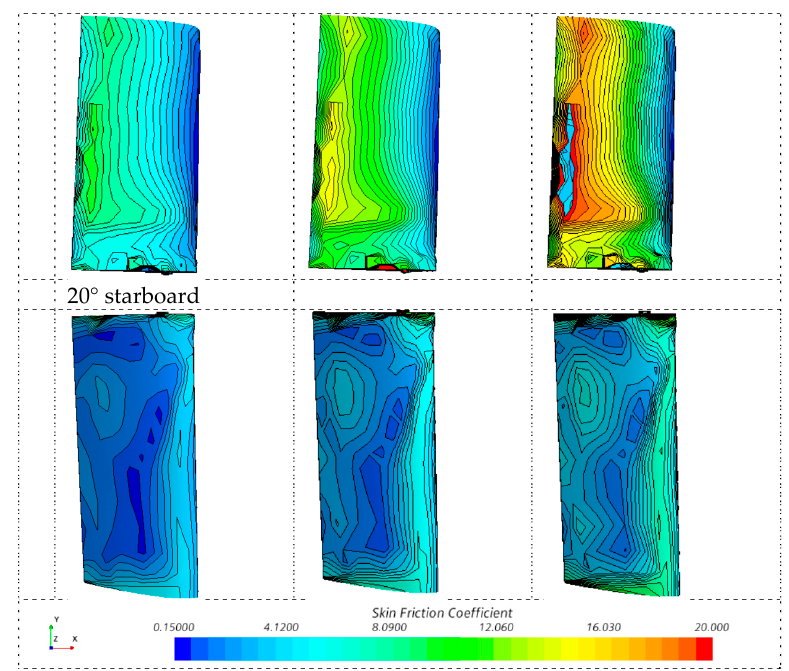
Figure 17. Detailed analysis for pressure and skin friction coefficients of each fin at various speeds in ship coordinates.